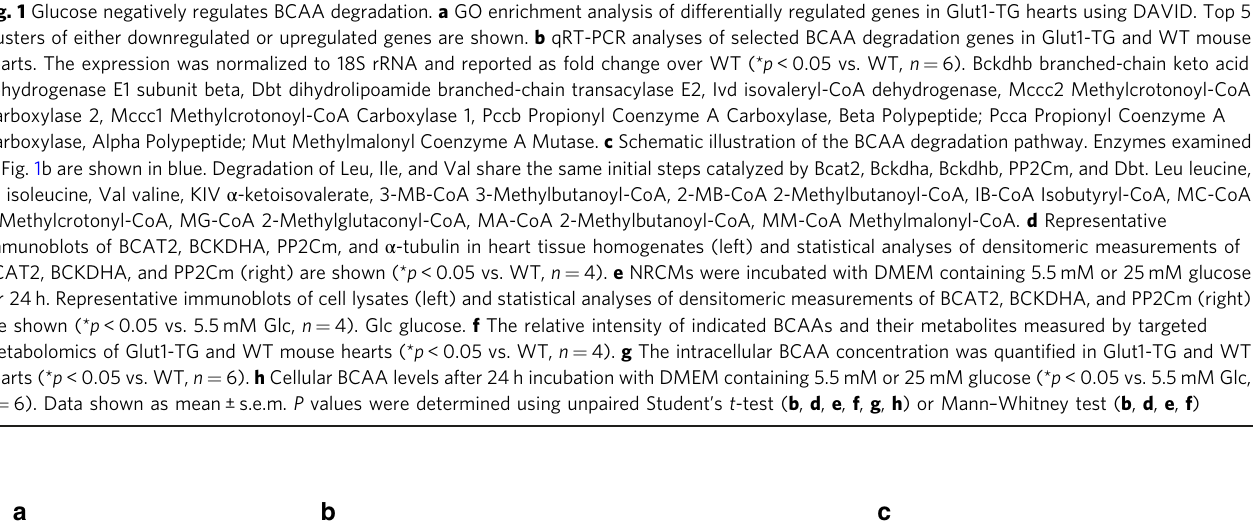
Fig. 1 Glucose negatively regulates BCAA degradation. a GO enrichment analysis of differentially regulated genes in Glut1-TG hearts using DAVID. Top 5 clusters of either downregulated or upregulated genes are shown. b qRT-PCR analyses of selected BCAA degradation genes in Glut1-TG and WT mouse hearts. The expression was normalized to 18S rRNA and reported as fold change over WT (* p < 0.05 vs. WT, n = 6). Bckdhb branched-chain keto acid dehydrogenase E1 subunit beta, Dbt dihydrolipoamide branched-chain transacylase E2, Ivd isovaleryl-CoA dehydrogenase, Mccc2 Methylcrotonoyl-CoA